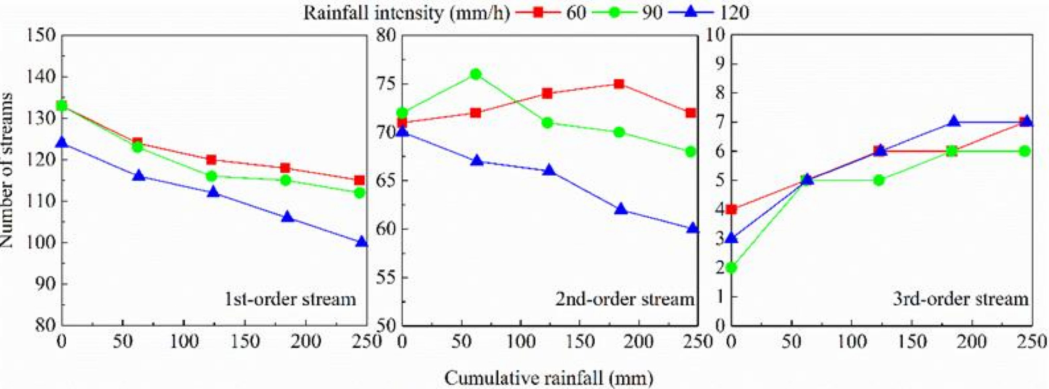
Figure 7. Changes of the steam numbers of different orders with cumulative rainfall (the stream order was classified by STRAHLER method).